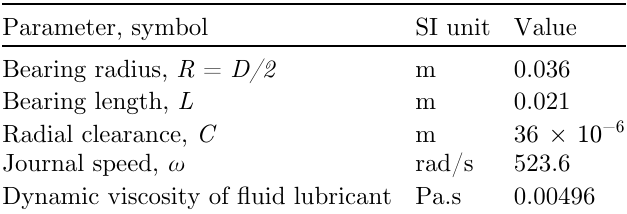
Table 1. Geometric characteristics and operating condi- tions of the Paranjpe ’ s main crankshaft bearing [47].